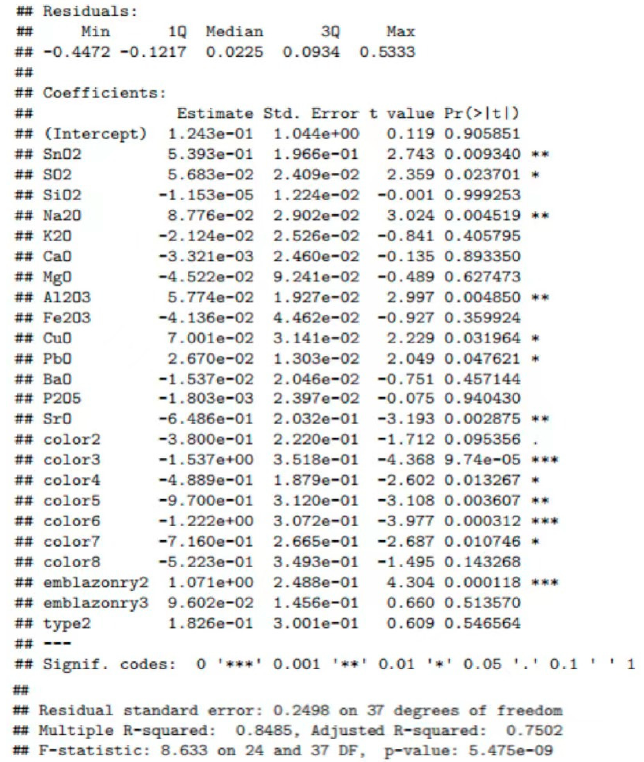
Figure 2. Correlation diagram among columns.